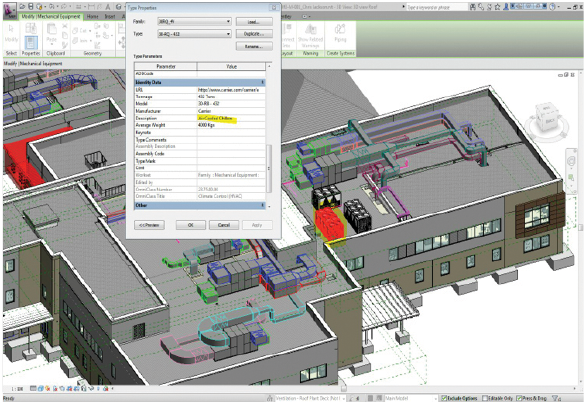
Figure 9. Schedule and view of the model.